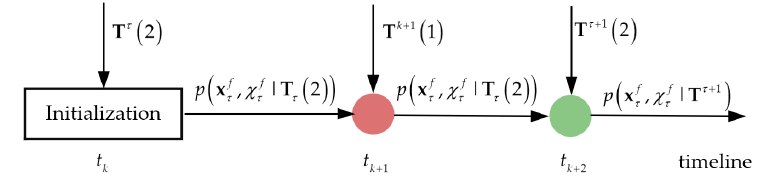
Figure 3. Fusion strategy framework of fusion center. The red circle in Figure 3 denotes that the gate fails and the track fusion is not per- formed and the green circle indicates that the gate is successful and the track fusion is performed. At time t k + 1 , the fusion center receives the local tracks T k + 1 ( 1 ) uploaded by the sonar 1 that cannot observe target A, so the number of equivalent measurements within the gate is 0. Therefore, the central track is not processed. At this time, the hybrid state (cid:12) (cid:17) (cid:16) (cid:12) ( 2 ) x f τ , χ f τ pdf of the central track is still p . At time t k + 2 , the fusion center receives the (cid:12) T τ OOSTs T τ + 1 ( 2 ) uploaded by the sonar 2 and the gate of the central track is successful.